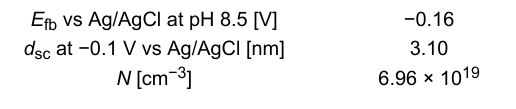
Table 1: Flat band potential E fb , space charge layer thickness d sc of the Schottky junction, and carrier density N in a mesoporous TiO 2 thin film coated on FTO obtained by the Mott–Schottky plots shown in Figure 4. d sc and N are average values when ε of TiO 2 = 85.8 and